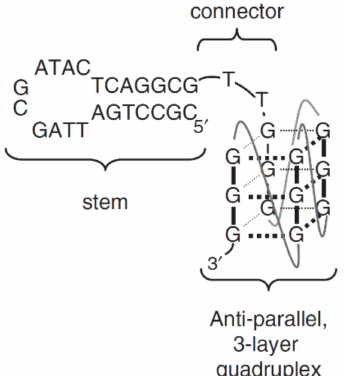
Figure 16. Schematic structure of quadruplex-hairpin junction [68]. Reproduced with permission from the Nucleic Acids Research and Oxford University Press.